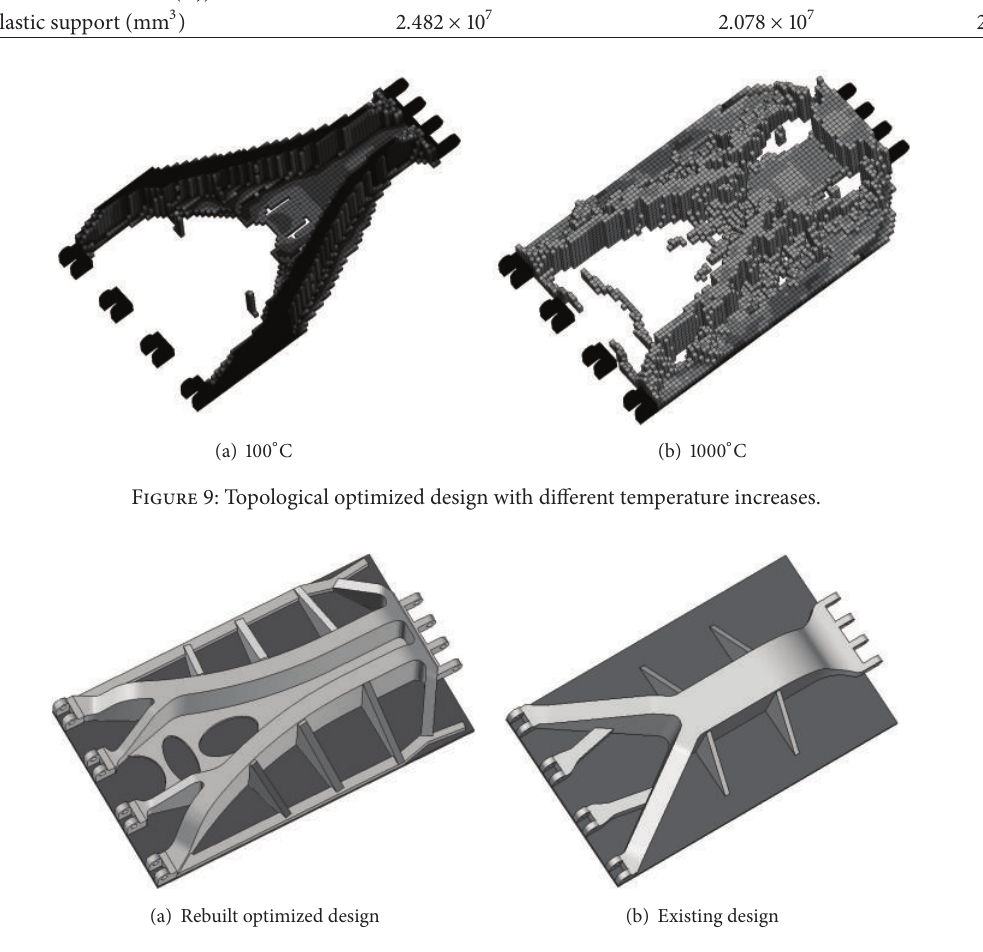
Figure 10: Rebuilt optimized design and existing design to be compared.